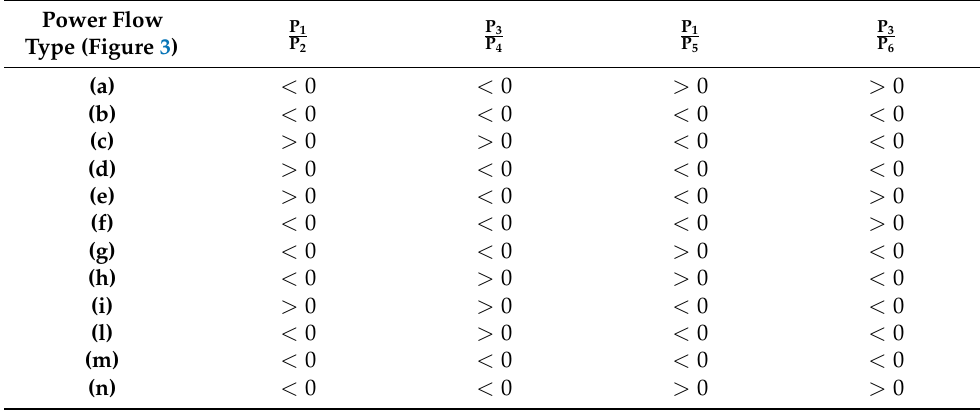
Figure 3. Power flow types within a type C compound transmission: twelve possible flows with different power circulations. Table 1. Power ratio signs required to obtain each power flow type.